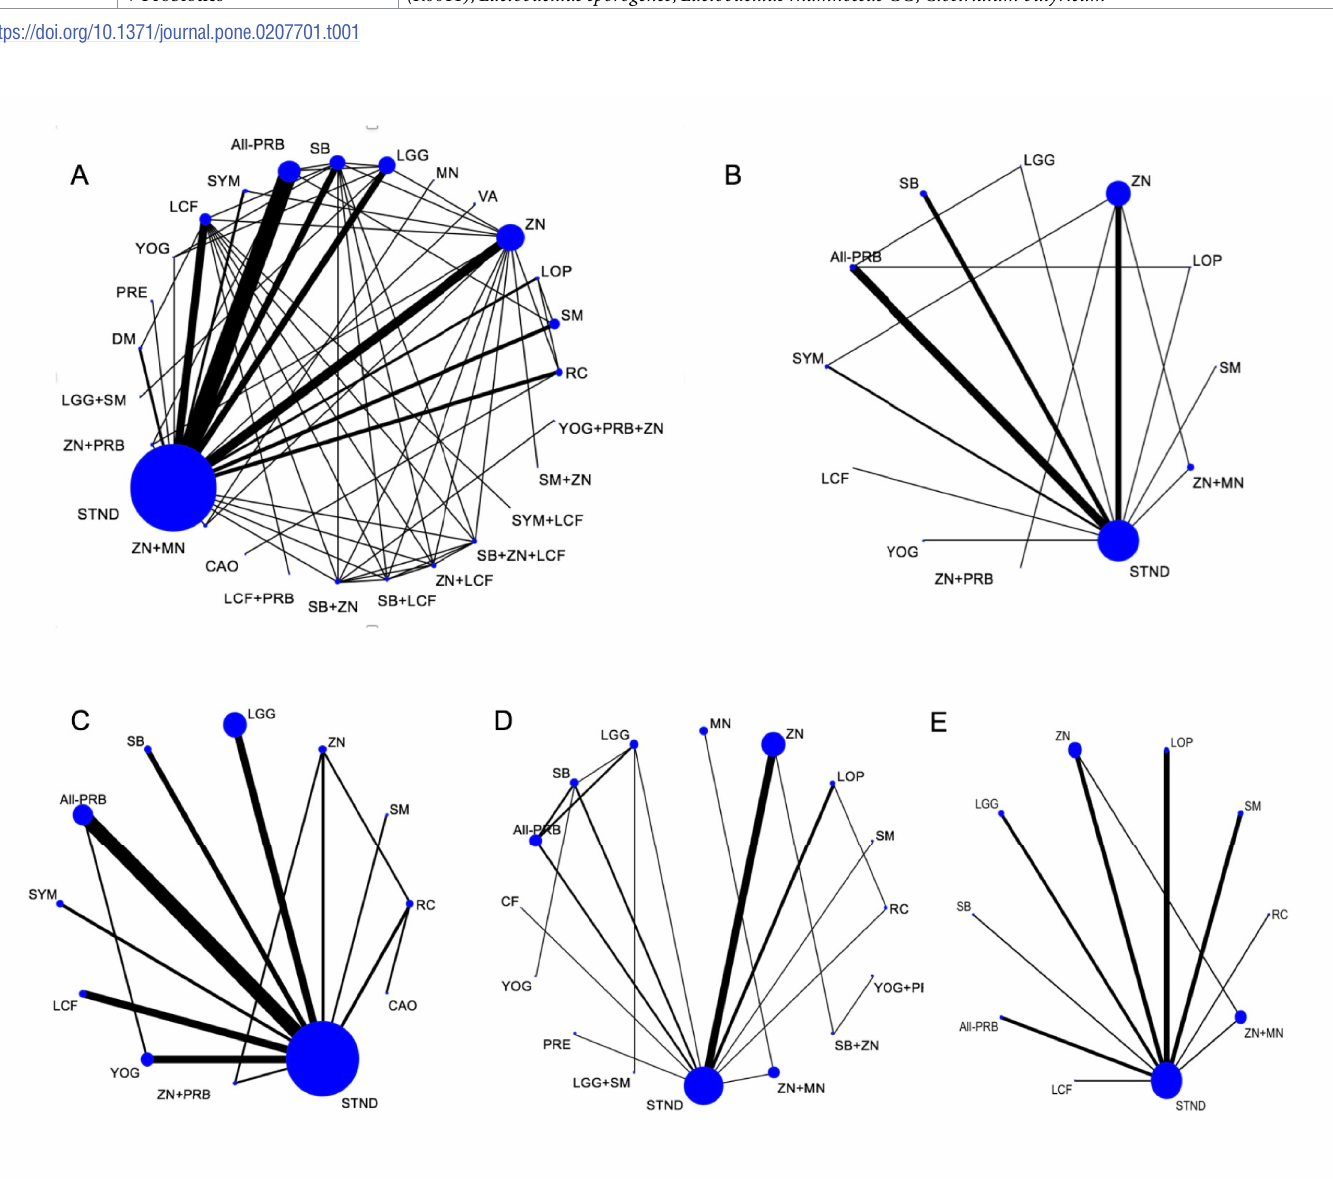
Fig 2. Network meta-analysis plots. (A) Diarrhea duration, (B) Stool Frequency at day 2, (C) Diarrhea at day 3, (D) Vomiting and (E) Side effects. Nodes are proportional to the number of patients included in the corresponding treatments, and edges are weighted according to the number of studies included in the respective comparisons. Interventions’ abbreviations: ALL-PRB: All probiotics, except LGG and SB; CAO: Kaolin-Pectin; DM: Diluted Milk; LCF: lactose-free formula; LCF+PRB: Lactose Free Formula + Probiotics; LGG: L . rhamnosus -GG; LGG+SM: LGG + Smectite; LOP: Loperamide; MN: Micronutrients; PRE: prebiotics; RC: Racecadotril; SB: Saccharomyces boulardii ; SB+LCF: S . boulardii + Lactose-Free Formula; SB+ZN: S . boulardii + Zinc; SB+ZN+LCF: S . boulardii + Zinc + Lactose free Formula; SM: Smectite; SM+ZN: Smectite + Zinc; STND: Standard treatment or Placebo; SYM: Symbiotics; SYM+LCF: Symbiotics + Lactose-Free Formula; VA: Vitamin A; YOG: Yogurt; YOG+PRB+ZN: Yogurt + Probiotics + Zinc; ZN: Zinc; ZN+LCF: Zinc + Lactose Free Formula; ZN+MN: Zinc + micronutrients; ZN+PRB: Zinc +